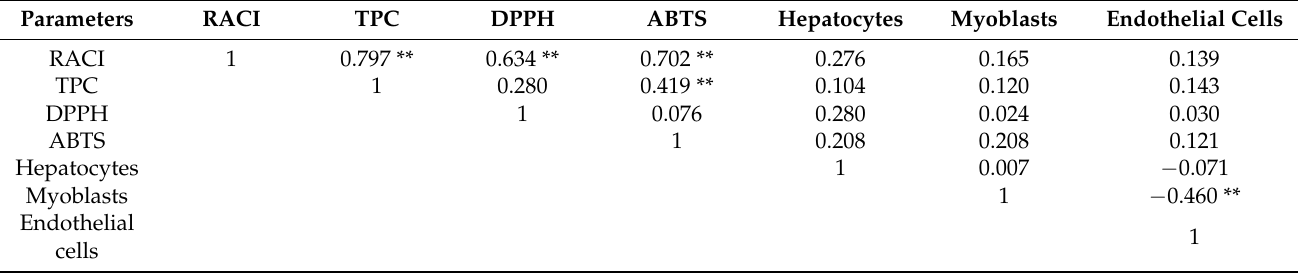
Table 3. Pearson’s correlations among antioxidant properties and cytoprotective activities in whole wheat extracts